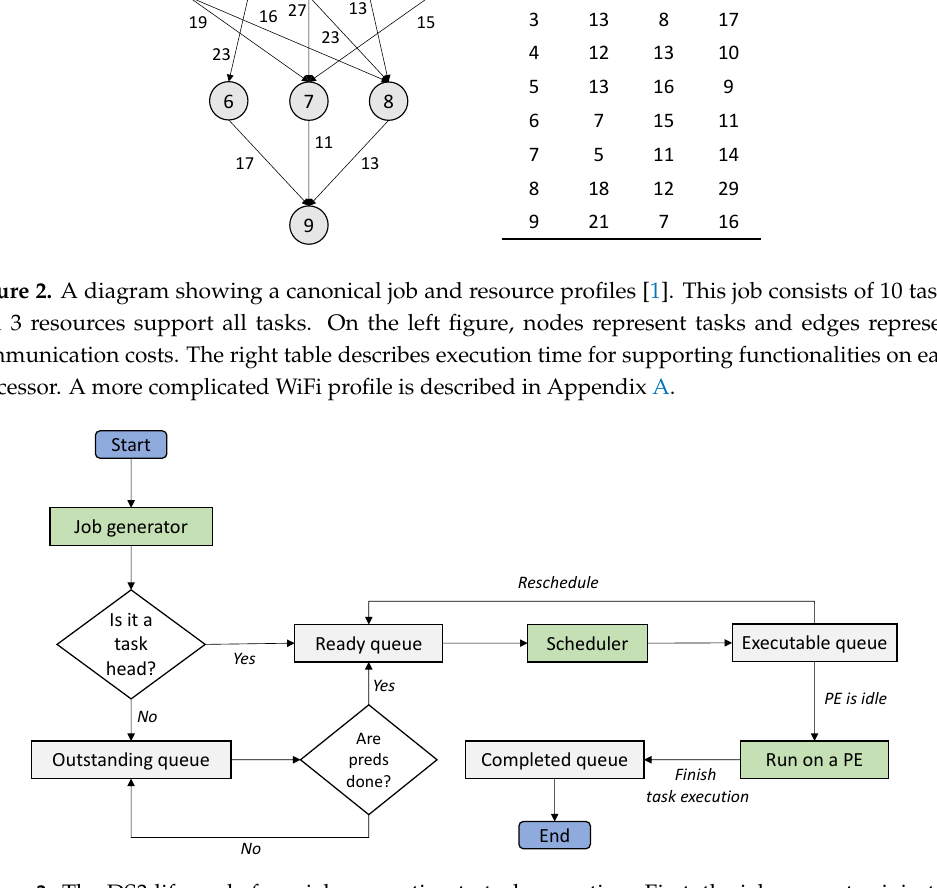
Figure 3. The DS3 life-cycle from job generation to task execution. First, the job generator injects a job to the job queue, and its tasks are loaded to the corresponding task queues. Then, the scheduler selects tasks in the ready queue, and assigns them to PEs, and the idle PEs run the scheduled tasks. Any task remained in the executable queue can be reloaded to the ready queue and rescheduled. Once the scheduled task is completed, it is moved to the completed